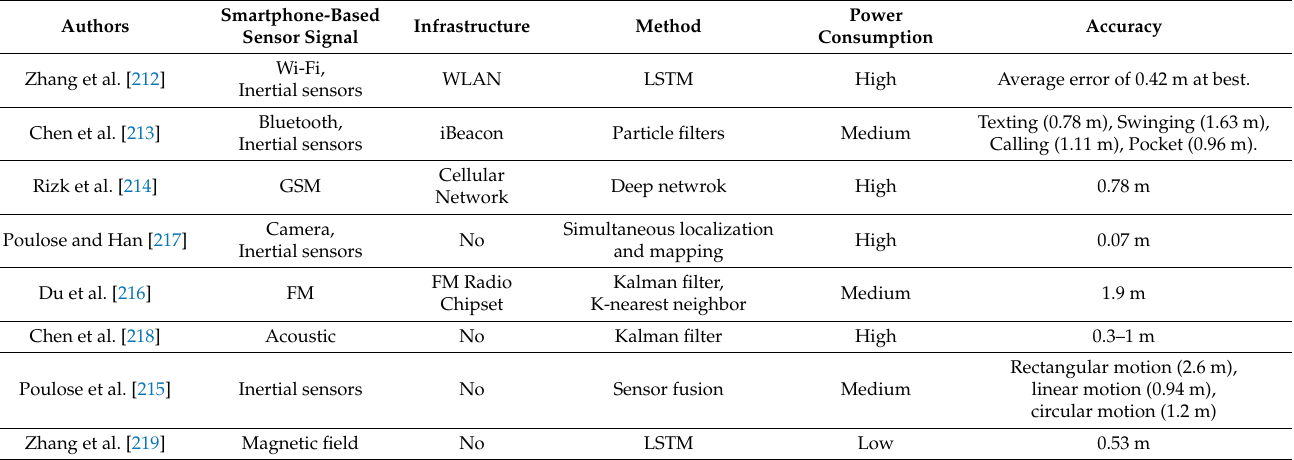
Table 7. Comparison of magnetic field with other techniques for smartphone-based indoor